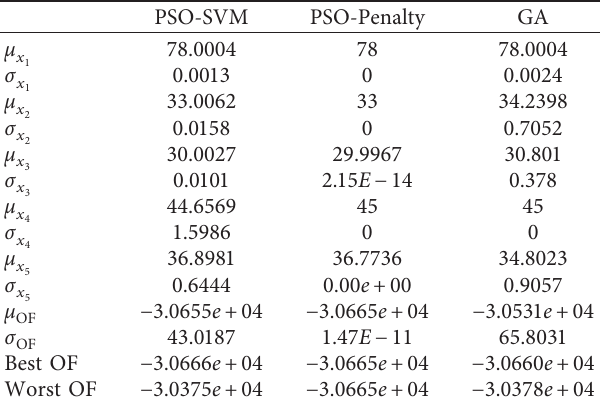
Table 3: Numerical example 2: results from PSO-SVM without relax constraints, PSO-Penalty, and GA (check Appendix and [46]).